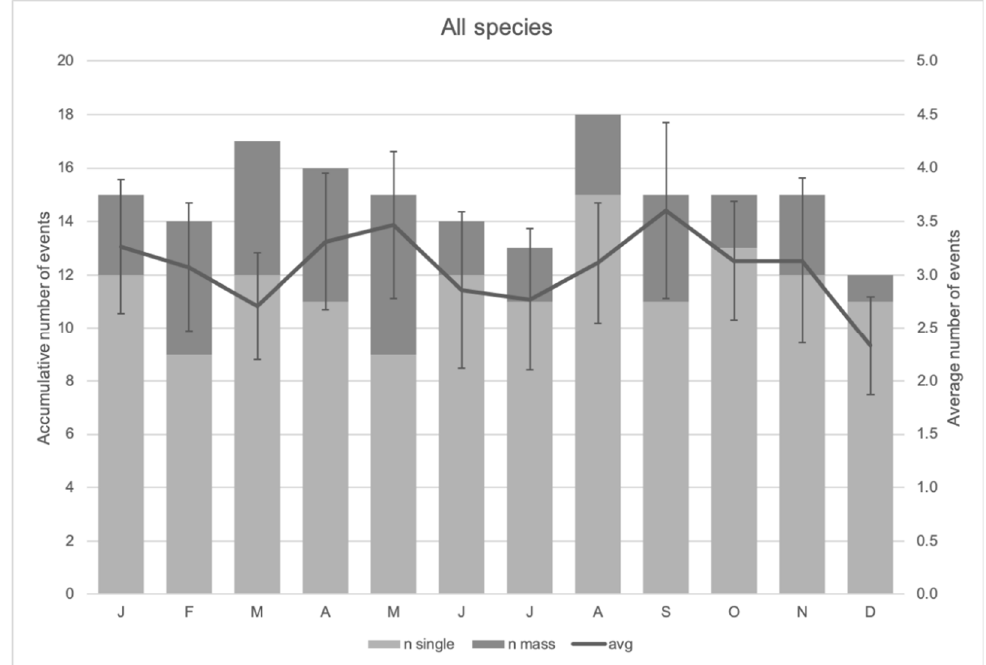
Figure 3. The monthly trend of cetacean stranding events in Indonesia.